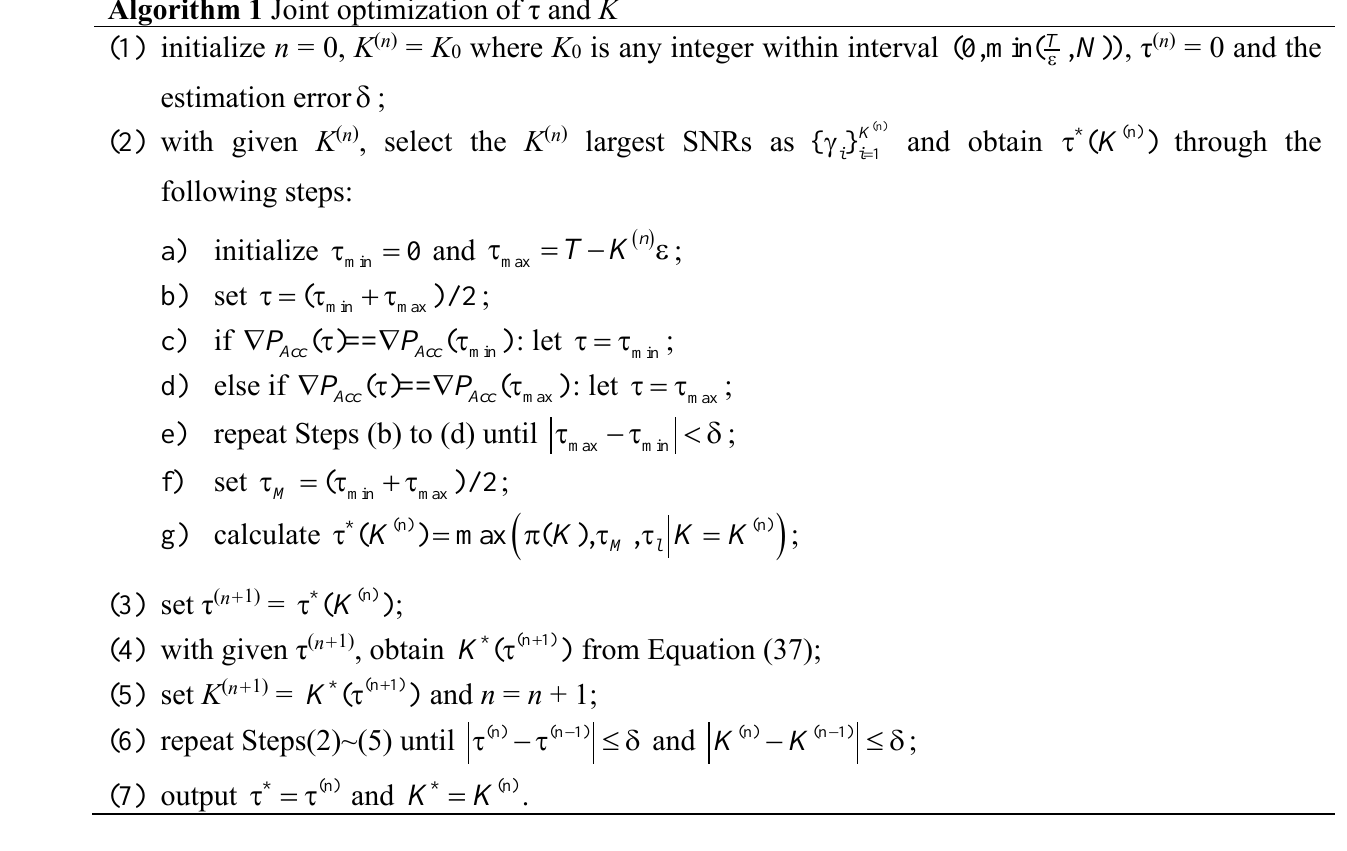
Algorithm 1 Joint optimization of τ and